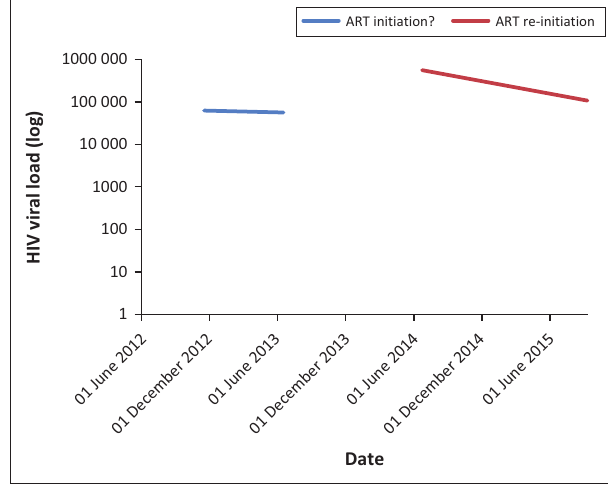
FIGURE 1: HIV viral load results over